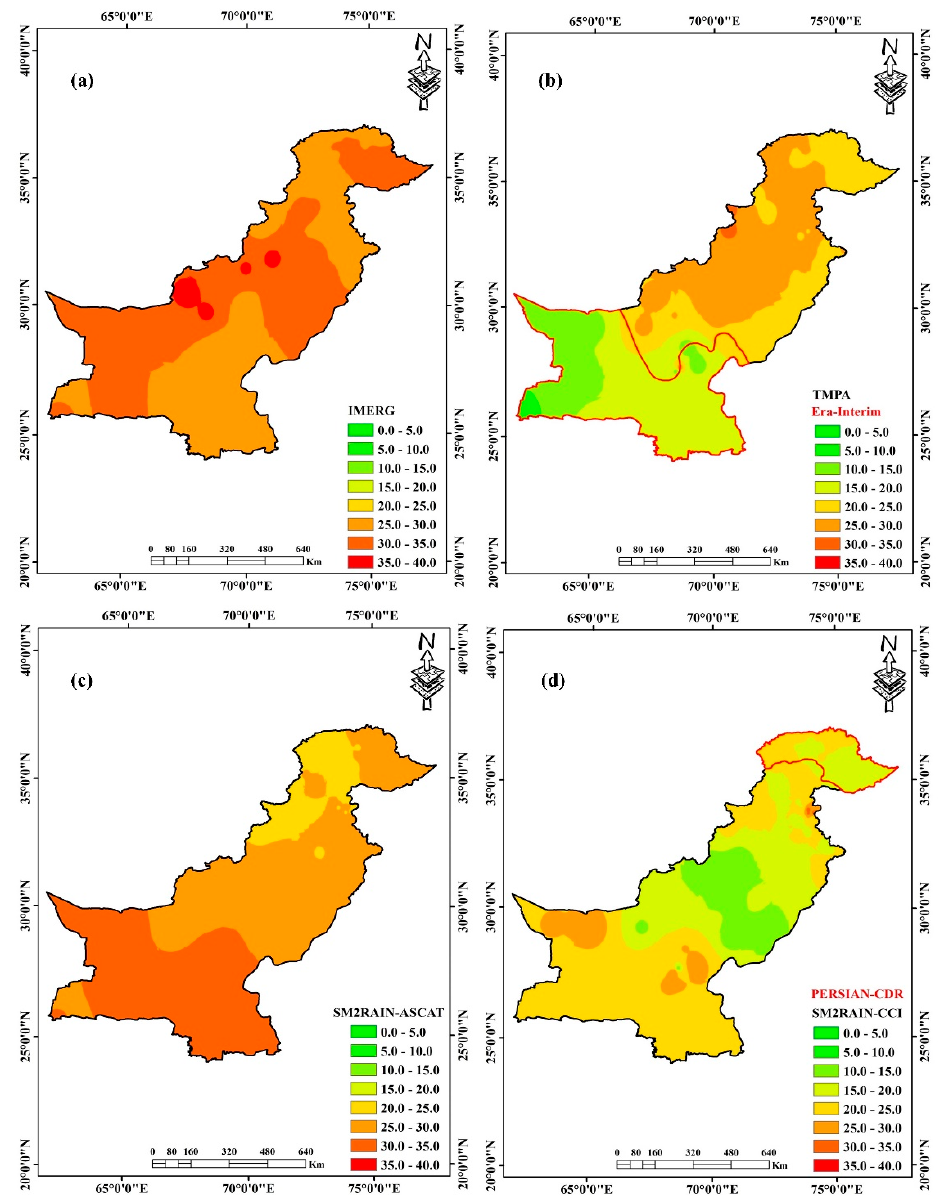
Figure 2. Spatial distribution of average WALS-RBPD weights of blending members, ( a ) IMERG, ( b ) TMPA and Era-Interim, ( c ) SM2RAIN-ASCAT, and ( d ) PERSIANN-CDR and SM2RAIN-CCI across Pakistan during 2007–2018.